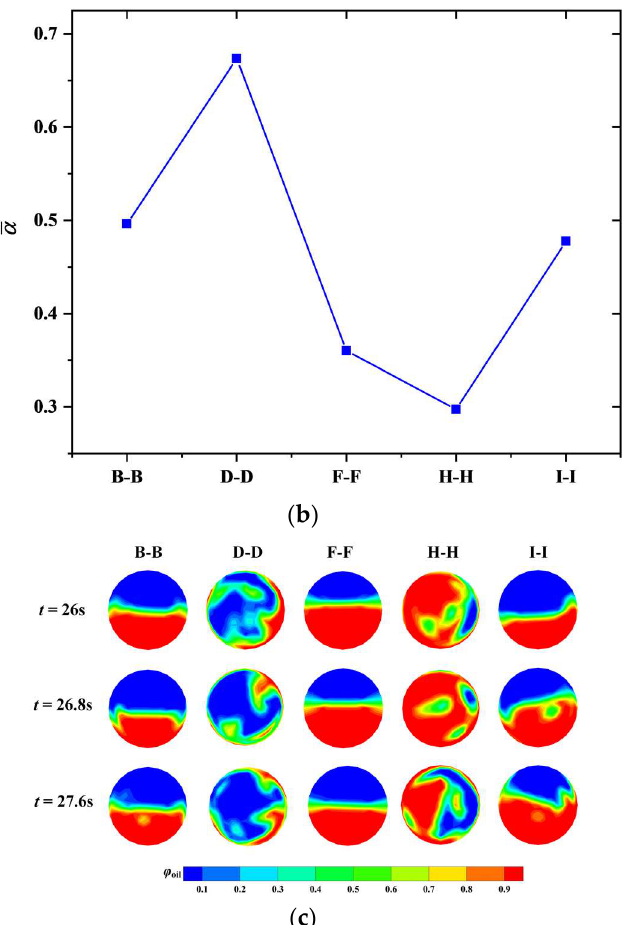
Figure 7. The gas void fraction at monitored sections of the static jumper in case 1, where ϕ gas is the gas void fraction, t is the flow time, α is the gas void fraction, α is the maximum time-averaged void fraction, and B-B, D-D, F-F, H-H and I-I denote the selected cross-sections along the jumper: ( a ) time histories of gas void fraction; ( b ) time-averaged gas void fraction; ( c ) the contours of oil volume fraction at three instants.